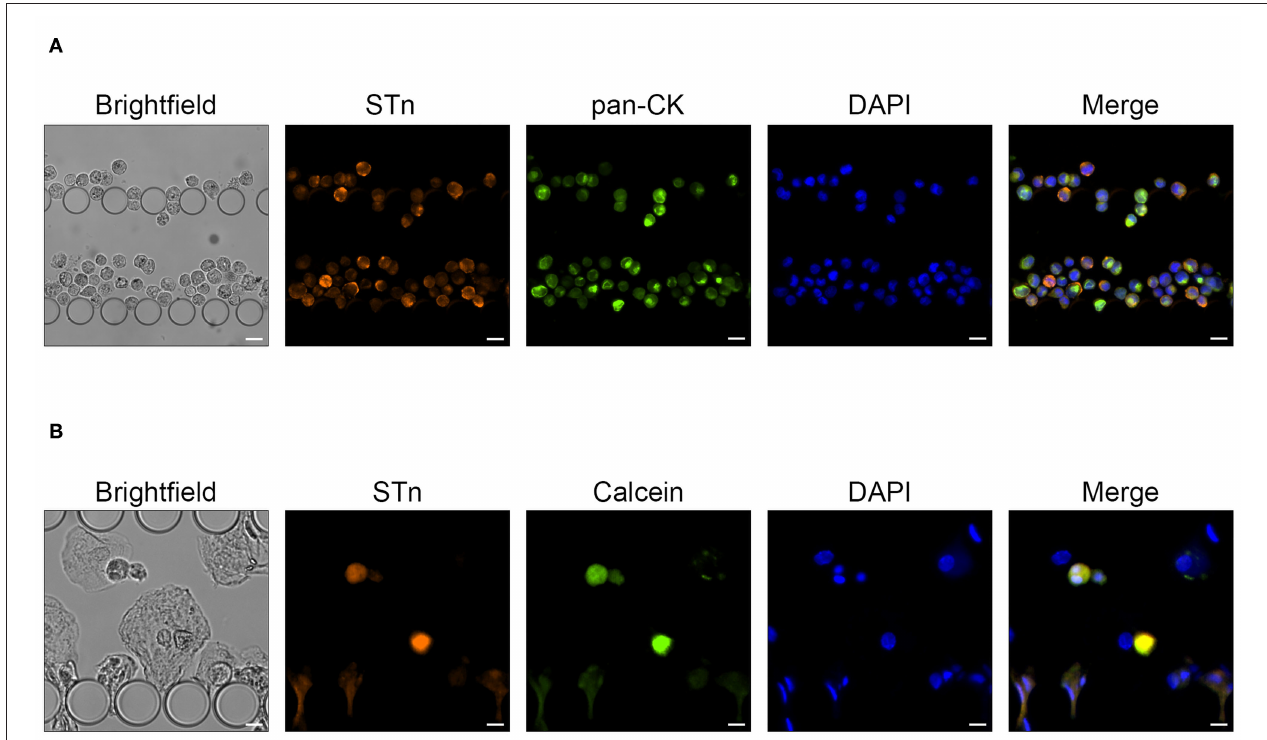
FIGURE 5 | MCR-STn bladder cancer cells captured in the UriChip. (A) Immunofluorescence analysis showing the pattern of STn (orange) and pan-CK (green) expression in UriChip-captured MCR-STn cells. STn is mostly expressed at the cell membrane and cytoplasm of cancer cells. Cell nuclei were stained with DAPI (blue). Scale bar, 25 µ m. (B) MCR-STn cells pre-labeled with calcein-AM (green) spiked in urine from healthy controls. Cell nuclei were stained with DAPI (blue). A capture efficiency of 53% was achieved. Scale bar, 15 µ